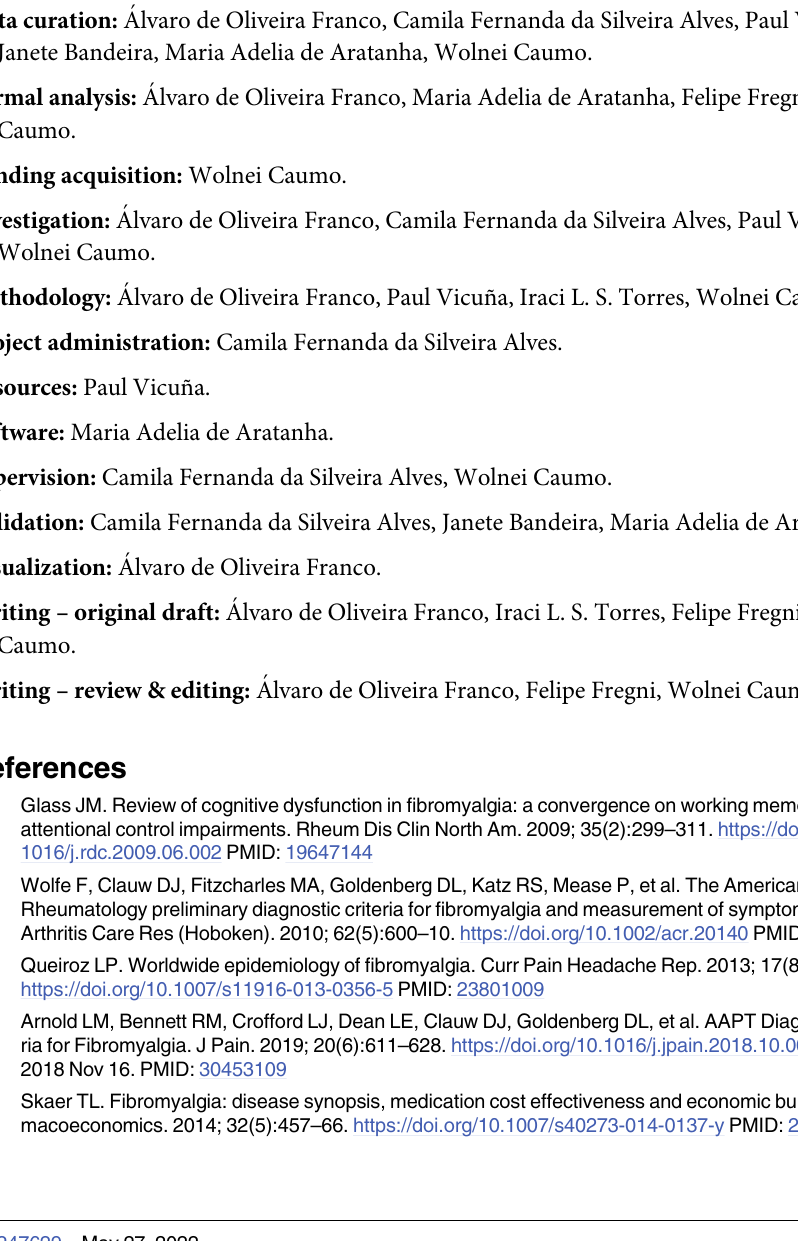
S1 Table. Supporting data. Underlying individual data with the corresponding captions on the